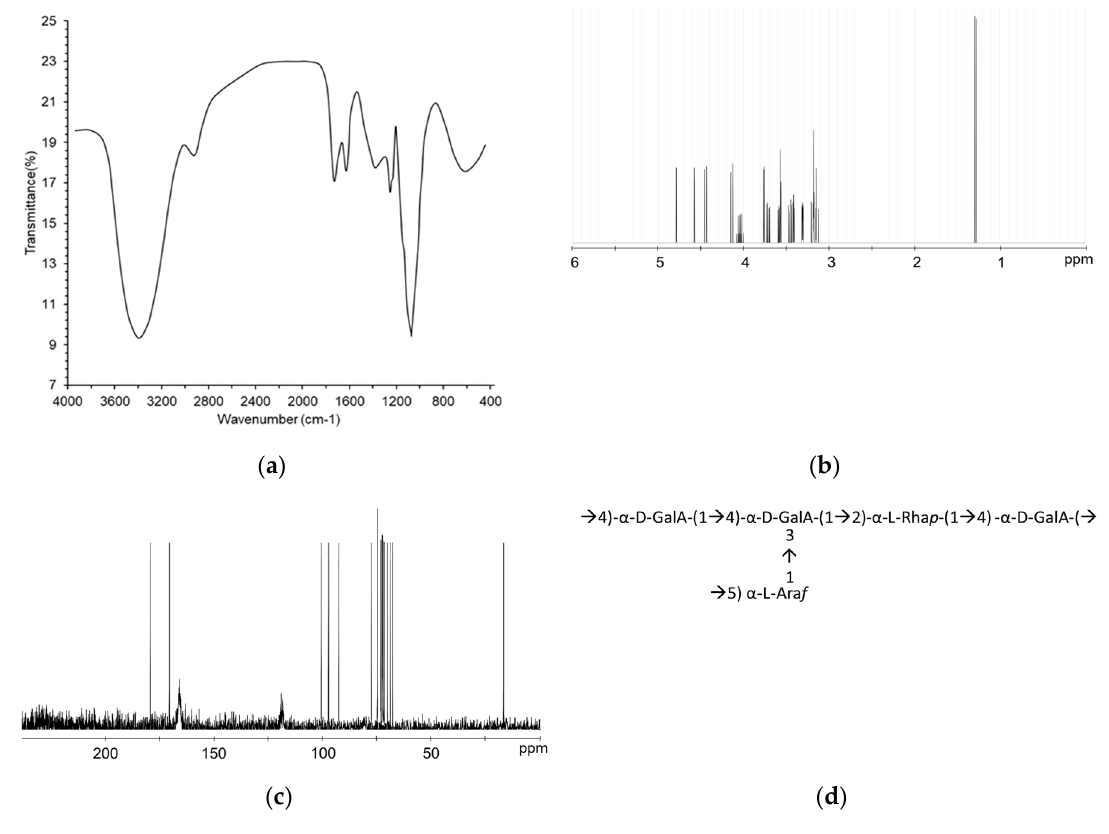
Figure 2. Fourier transform infrared spectra ( a ); 1 H-NMR spectra ( b ); 13 C-NMR spectra ( c ); and